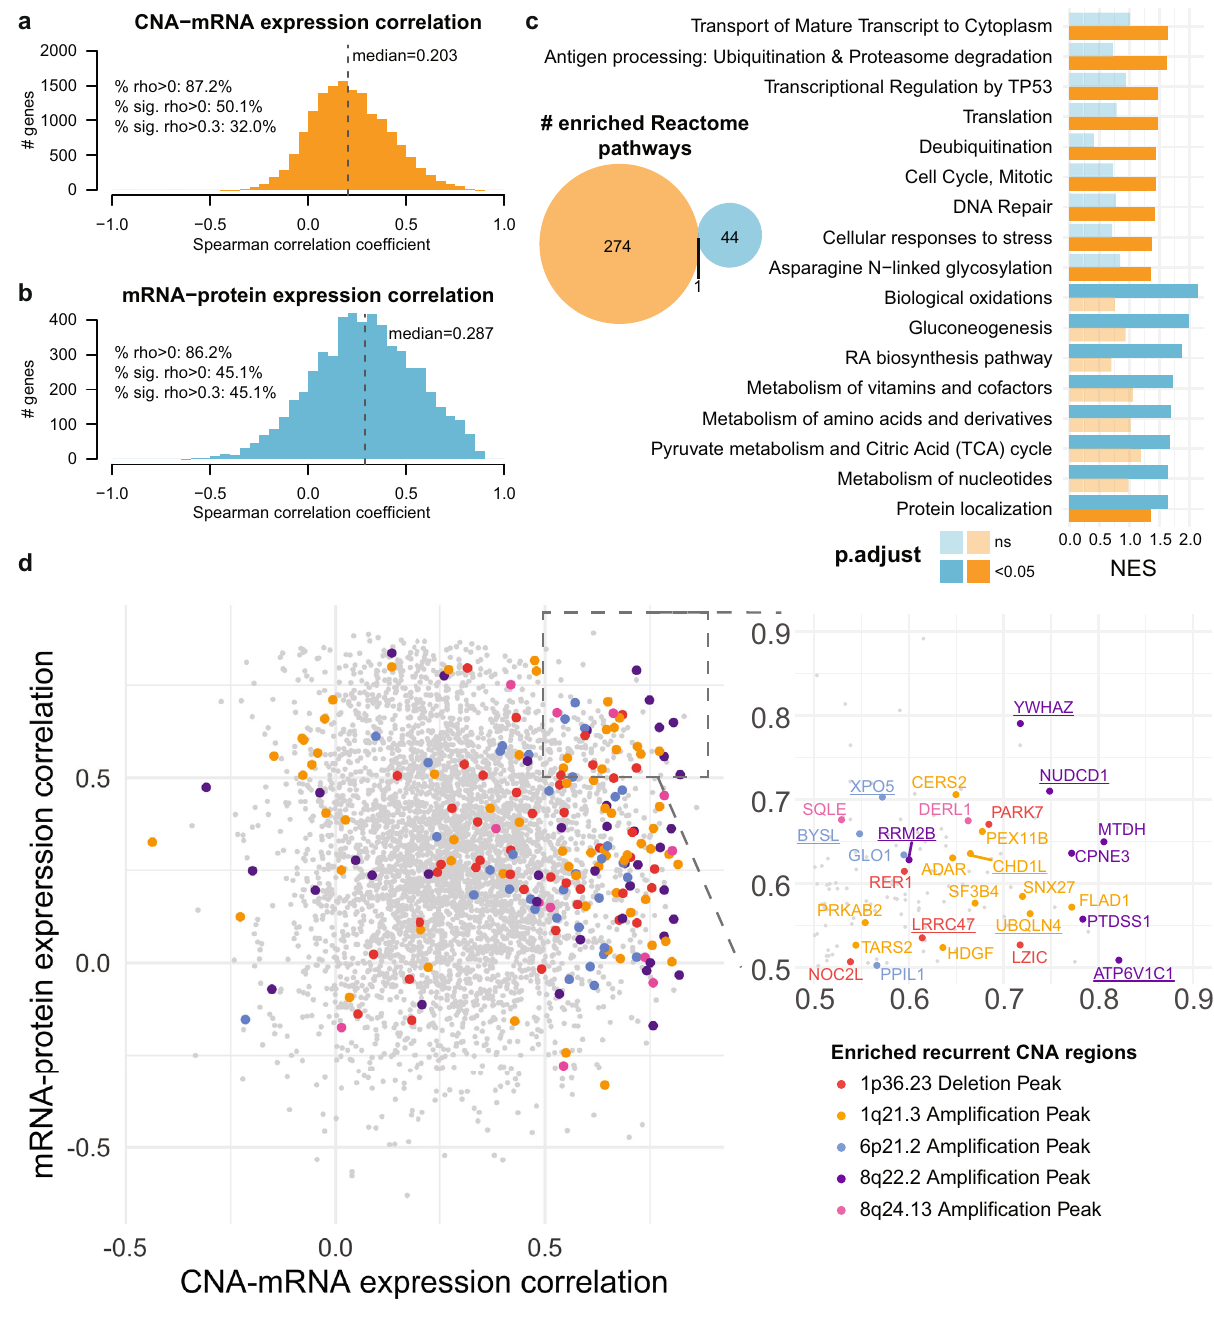
Fig. 2 CNA-mRNA-protein correlation. Histograms of the distributions of the per-gene Spearman correlation coef fi cients ( a ) for CNA-mRNA and ( b ) mRNA-protein expression. sig.: signi fi cant. c Venn diagram of the number of enriched Reactome pathways for genes/proteins ranked by CNA-mRNA expression correlation (orange) and mRNA-protein expression correlation (blue). Enrichment and statistical signi fi cance were de fi ned by gene set enrichment analysis. Multiple correction was performed using the Benjamini – Hochberg method. Barplot of selected Reactome pathways enriched among genes with high CNA-mRNA expression correlation (orange) and/or with high mRNA-protein expression correlation (blue). Statistically signi fi cant normalized enrichment scores (NES, p < 0.05) are shown in darker shades (dark orange/blue) while non-signi fi cant NESs are shown in lighter shades (light orange/blue). d Scatterplot of the per-gene Spearman correlation coef fi cients ( y -axis) between mRNA and protein expression against (x-axis) between CNA and mRNA. Genes in fi ve of the recurrently altered regions as de fi ned by GISTIC2 are colored according to the color key. Inset shows the genes with >0.5 correlation coef fi cients in both comparisons. Dysregulated genes (compared to normal livers) on both the mRNA and protein levels are underlined. Source data are provided as a Source Data fi ( p = 0.001) and associated with HBV ( p = 0.010, Supplementary ( p = 0.012, Fisher ’ s exact test) 40 . While CTNNB1 -mutant tumors Fig. 10 and Supplementary Data 10). A multivariate Cox- were more frequently lower grade (Edmondson grade, p = 0.017) proportional hazard model suggests that CDKN2A , GPAM , and were associated with the immune-desert phenotype KEAP1 and TSC2 mutations are associated with poor overall ( p = 0.039) 42,43 , TP53 -mutant tumors were of higher grade